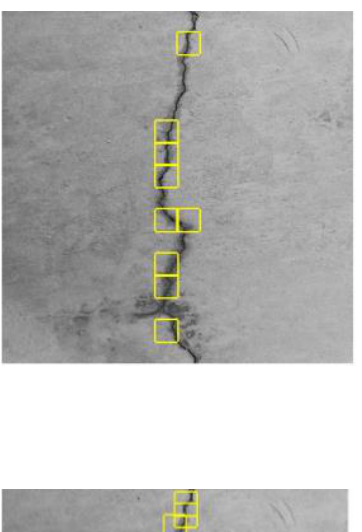
Figure 9. Crack position detection (CPD) results using the ( a ) constructed CPD and ( b ) Alexnet network.